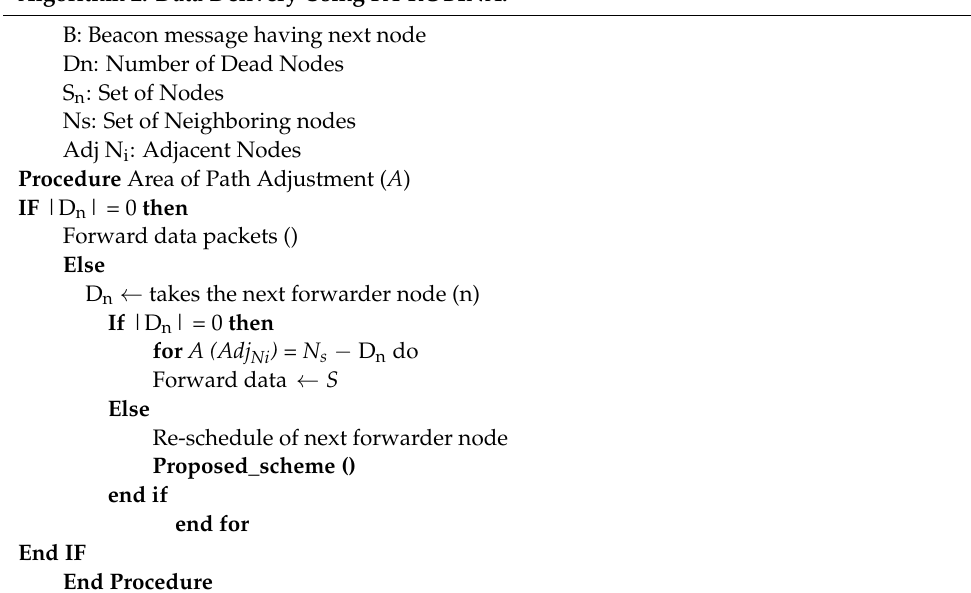
Figure 6. Proposed working mechanism of PA-ROBINA and PL-ROBINA. Algorithm 2: Data Delivery Using